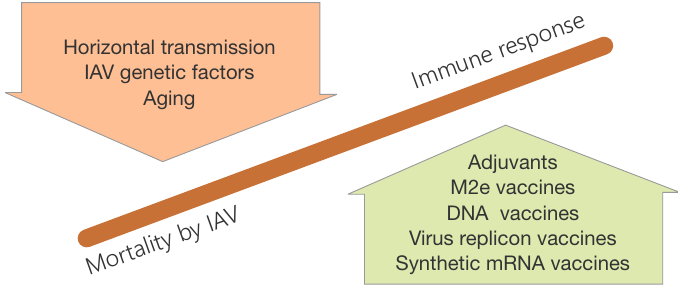
Figure 10. Emerging vaccination strategies. Novel vaccination strategies can for example (i) enhance mucosal IR against IAV reducing horizontal transmission and virus spread; (ii) display improved efficacy in poor responders such as